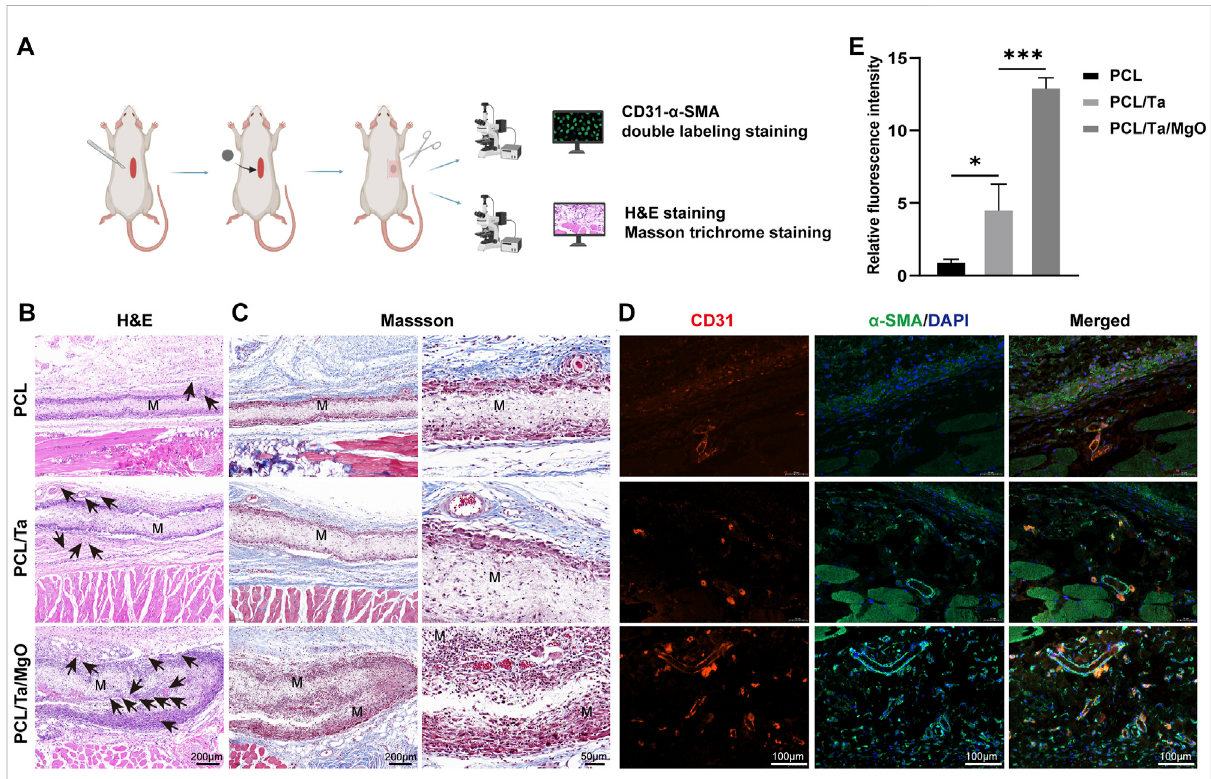
FIGURE 6 Evaluation of the in vivo subcutaneous biocompatibility and angiogenesis of different membranes at day 14 after implantation. (A) Schematic draft of subcutaneous implantation test. (B) Representative images of H&E staining. Black arrows: blood vessels; M: membranes. (C) Representative imagesofMasson ’ strichromestainingandamagni fi edviewofthemembraneregion. (D) Representativeimagesofimmuno fl uorescencestainingfor CD31 and a -SMA. (E) Relative fl uorescence intensity of CD31. ( n = 3) (* p < 0.05, ** p < 0.01, *** p < 0.001, and **** p <